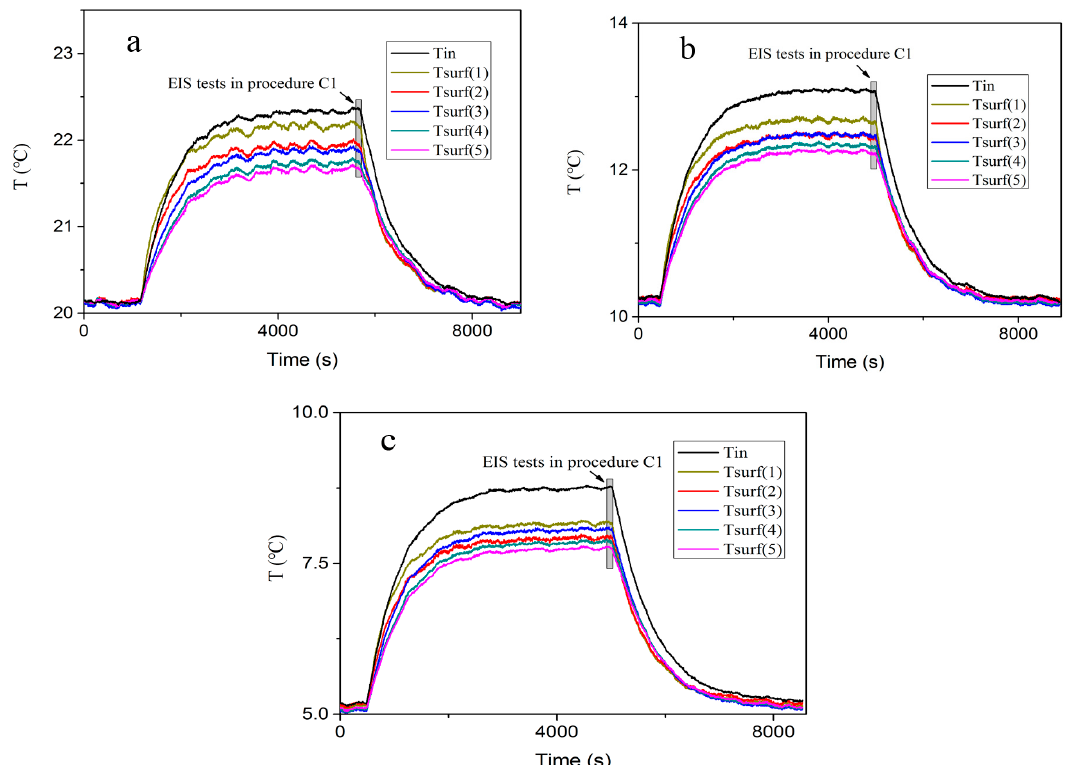
Figure 7. Battery temperatures during the test procedures C1. Battery temperatures at ( a ) 20 °C; ( b ) 10 °C; and ( c ) 5 °C.